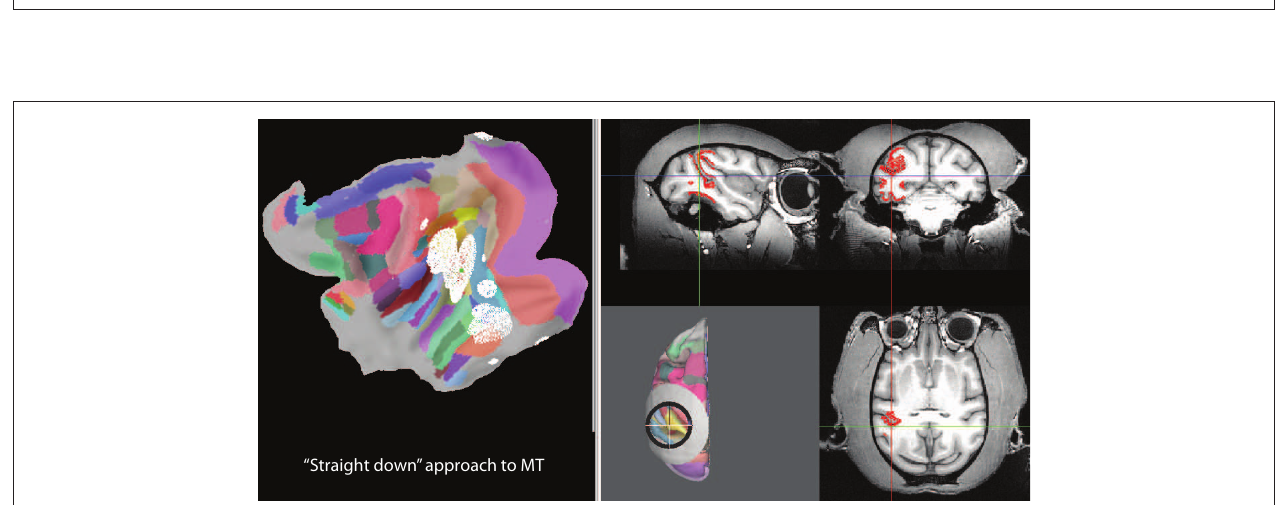
Figure 5 | Visualization of all parts of the brain that can be accessed with the default recording chamber placement. The left panel shows all accessible nodes marked in white on the flattened representation of the cortical sheet. Likewise, all accessible nodes are marked in red on the MRI on the right side.